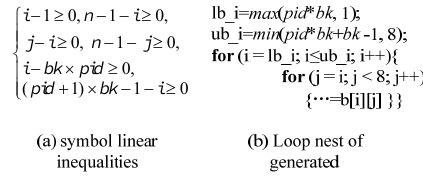
Figure 3. Symbol linear inequalities